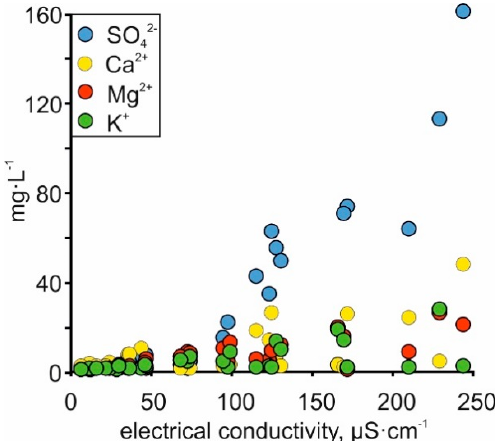
Figure 5. Values of electrical conductivity in streams and subsurface water on the catchments of lakes Saana ( a ) and Saanalampi catchment ( b ).